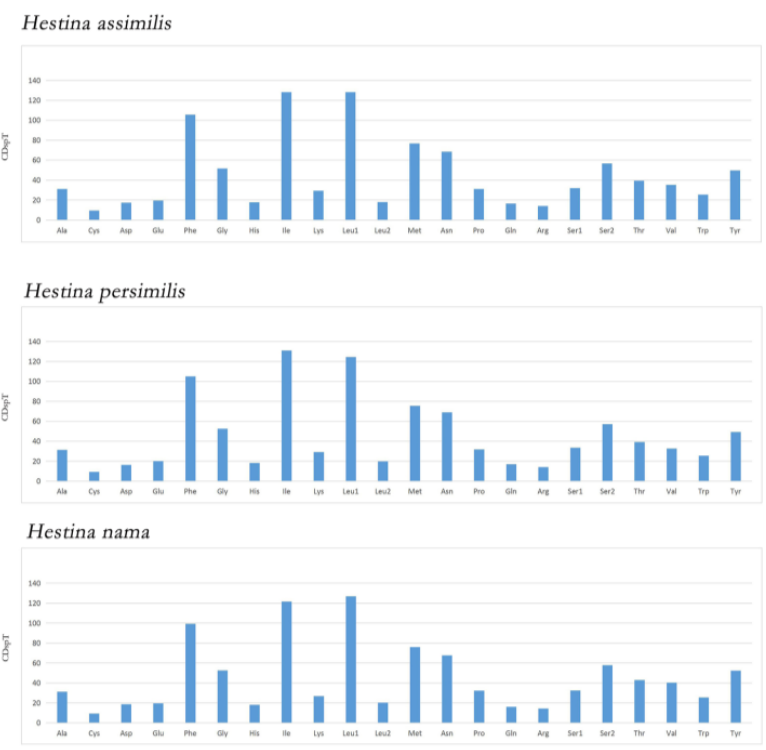
Figure 4. Codon distributions in the mitogenomes of twelve Apaturinae species. CDspT: codons per thousand